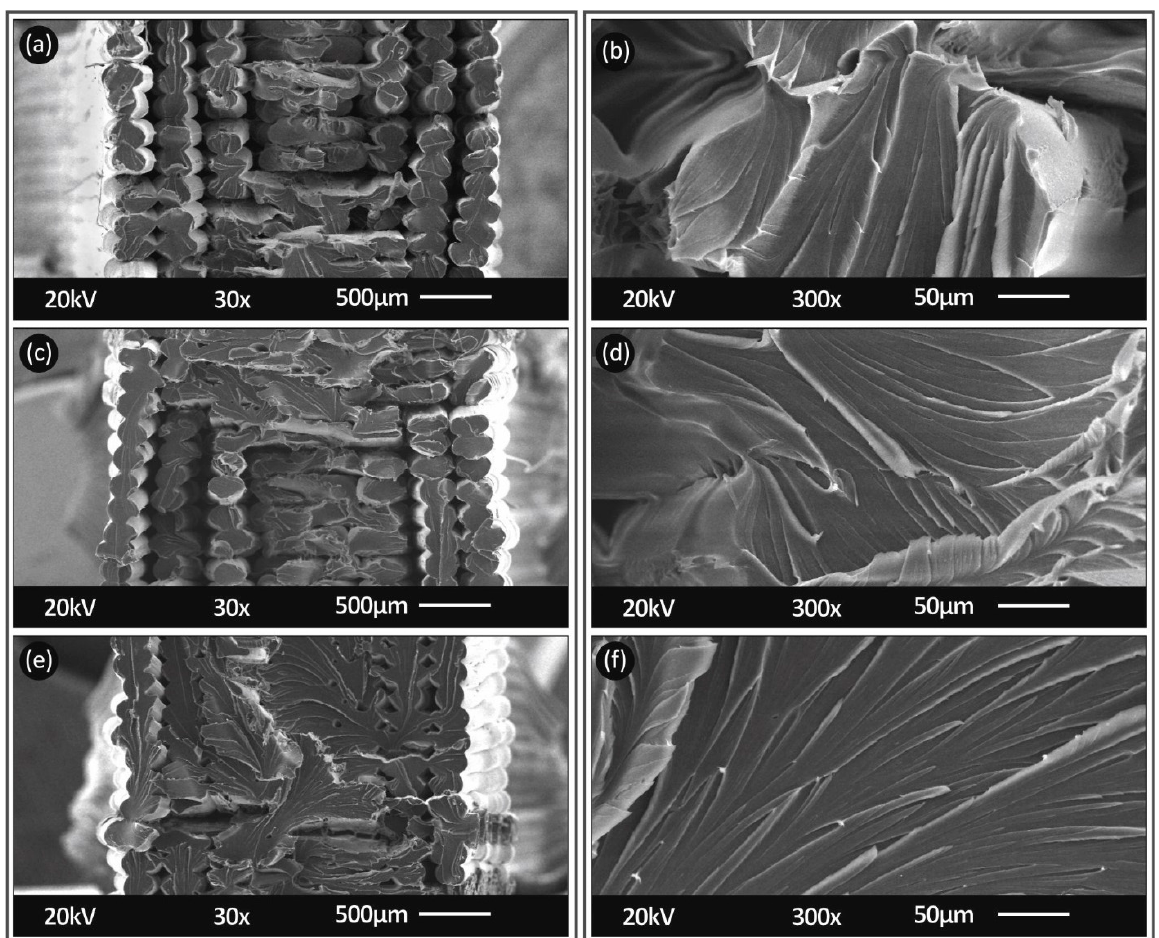
Figure 12. Fracture area SEM captures from PC specimens (built at a 260 °C nozzle temperature, with a 0.2 mm layer thickness) at different elongation speeds of 10 mm/min ( a , b ), 100 mm/min ( c , d ) and 300 mm/min ( e , f ) at 30× ( a , c , e ) and 300× ( b , d , f ) magnifications.